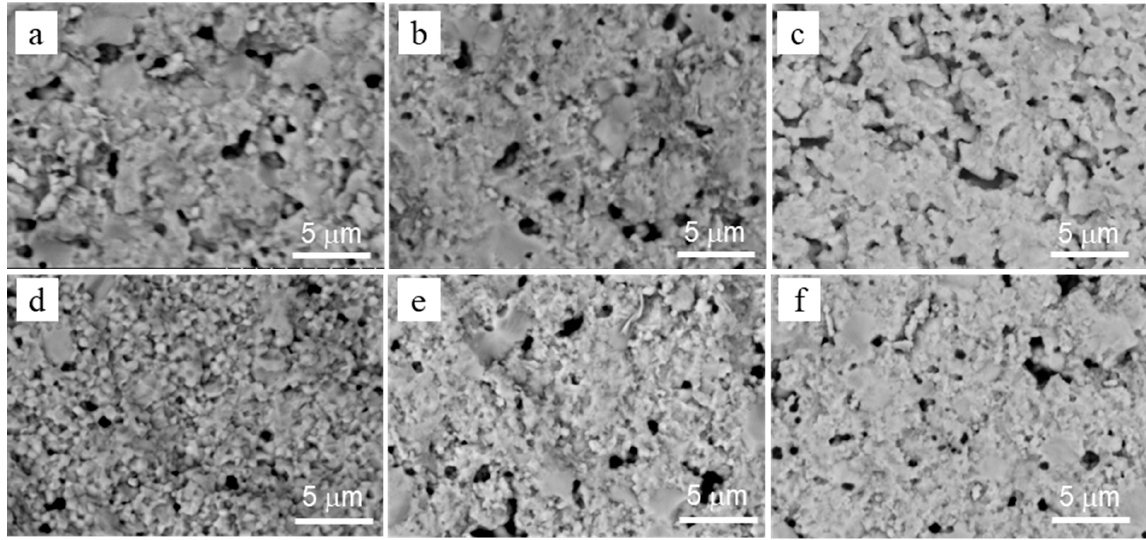
Figure 8. SEM-BSE fractography for ( a – c ) 3YSZ and ( d – f ) 6YSZ ceramics sintered at ( a , d ) 1550, ( b , e ) 1500, and ( c , f ) 1450 °C.